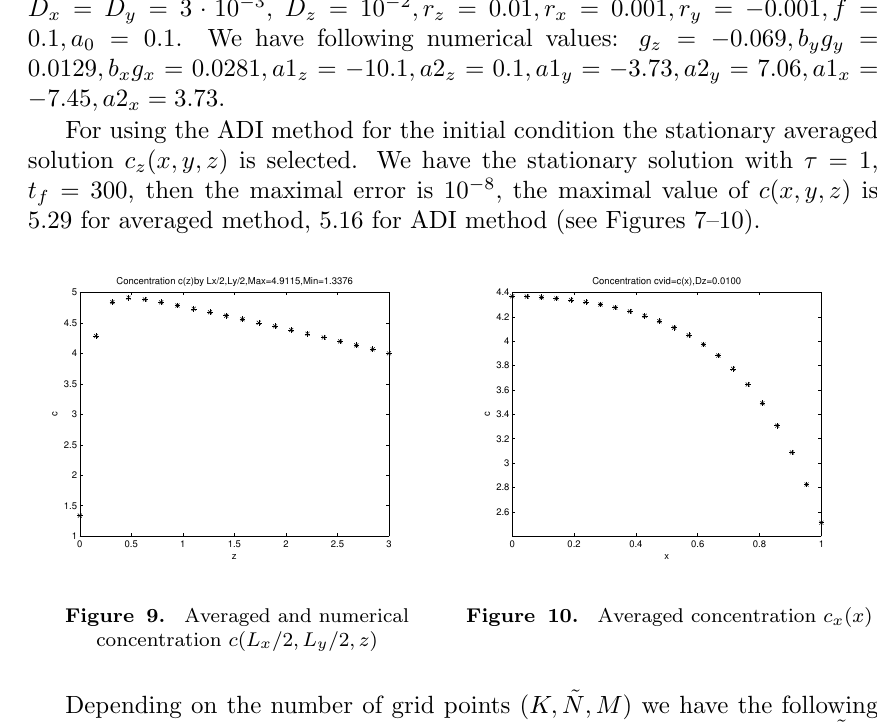
Figure 10. Averaged concentration c x ( x )